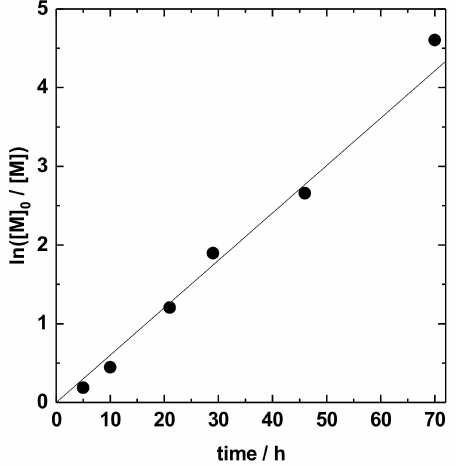
Figure 1. Plot of ln([ M ] 0 /[ M ]) versus t for the solution polymerization of N,N -diethyl- N -(2- methacryloylethyl)- N -methylammonium bis(trifluoromethylsulfonyl)imide (DEMM–TFSI, 80 wt%) in N,N -diethylmethyl(2-methoxyethyl)ammonium (DEME)–TFSI at 70 ◦ C: [DEMM–TFSI] 0 /[ethyl 2-bromoisobutyrate] 0 /[Cu(I)Cl] 0 /[Cu(II)Cl 2 ] 0 /[2,2 (cid:48) -bipyridine] 0 =